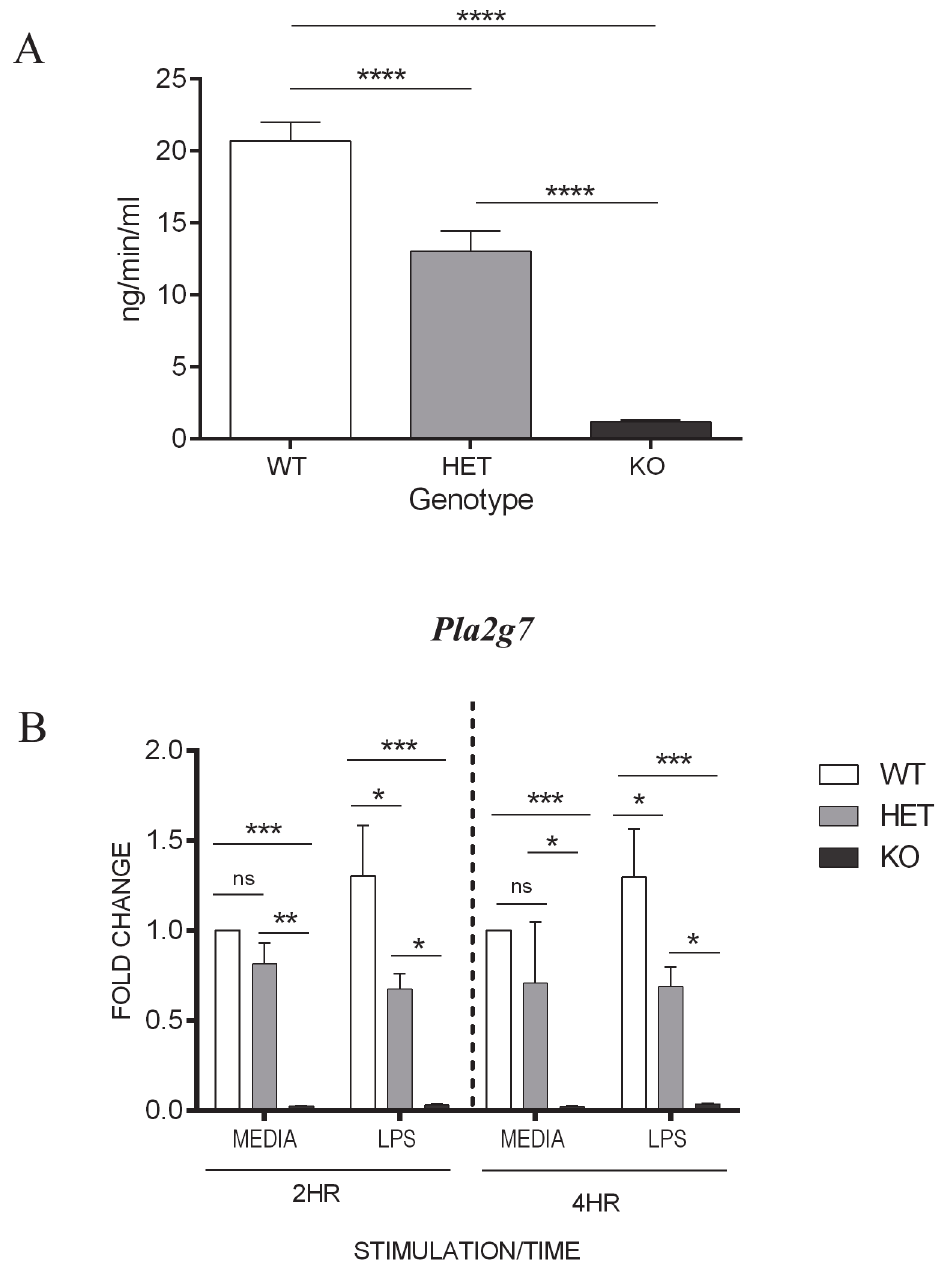
Fig 1. Quantification of Lp-PLA2 enzyme activity and gene expression in murine plasmas and BMDM. A) Enzyme analysis of Lp-PLA 2 activity from murine cardiac blood samples (n = 15 – 17) **** p < 0.001. B) RT-qPCR quantification of BMDM Pla2g7 expression (n = 3). Lp-PLA 2 WT, HET and KO BMMO were stimulated with LPS or media only for 2 or 4 hours, and gene expression analysed. Pla2g7 mRNA expression normalized by GAPDH. * p < 0.05 ** p < 0.01 *** p < 0.005